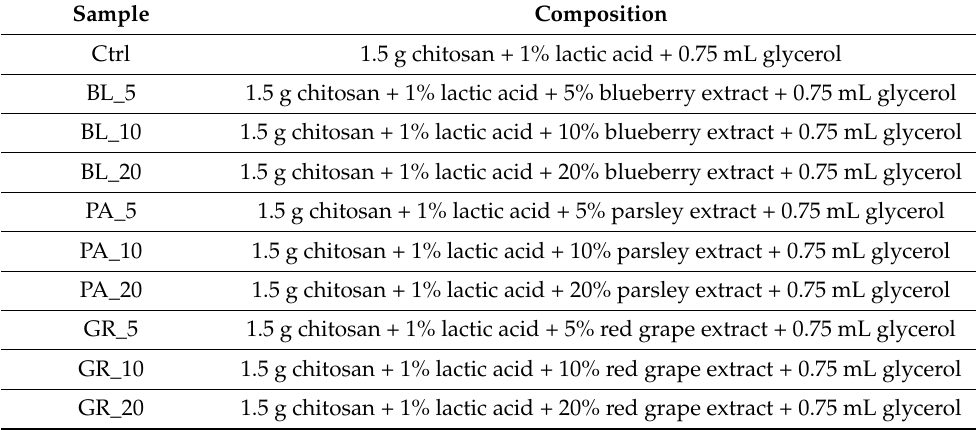
Table 2. Composition of edible